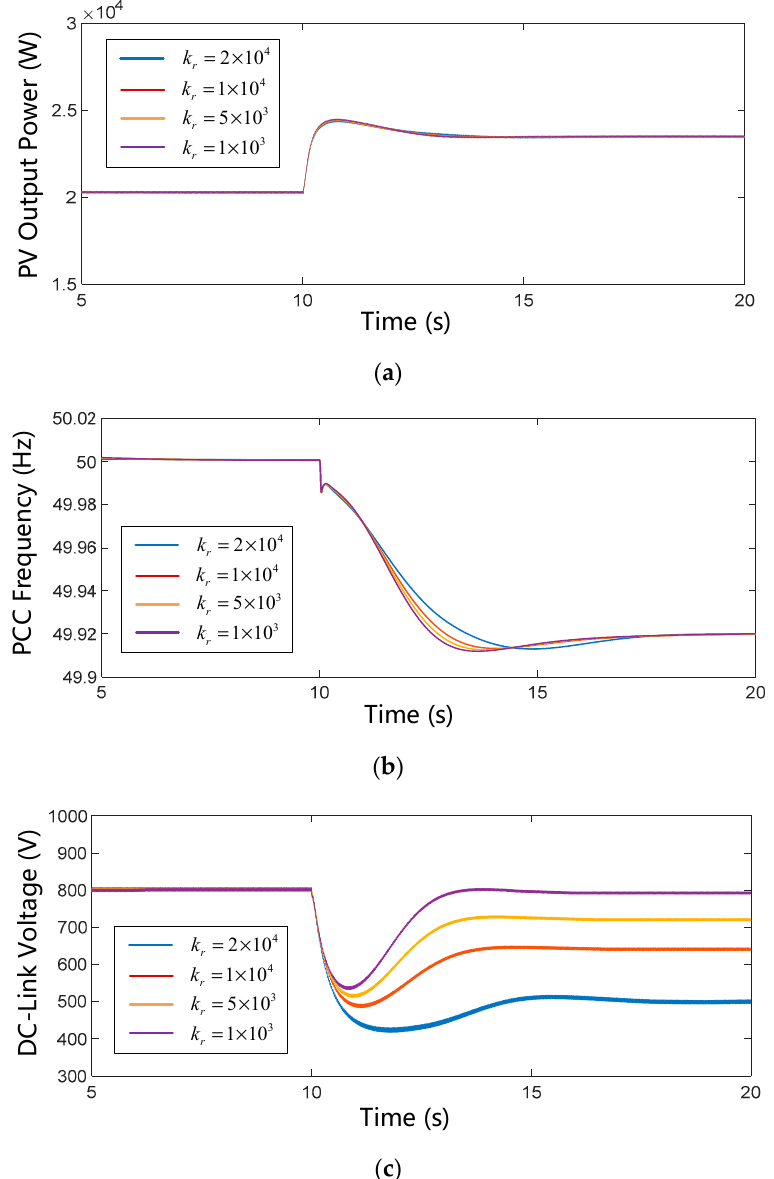
Figure 11. Simulation results of the proposed control method with different values of k r : ( a ) PV output power, ( b ) PCC frequency, and ( c ) DC-link voltage.